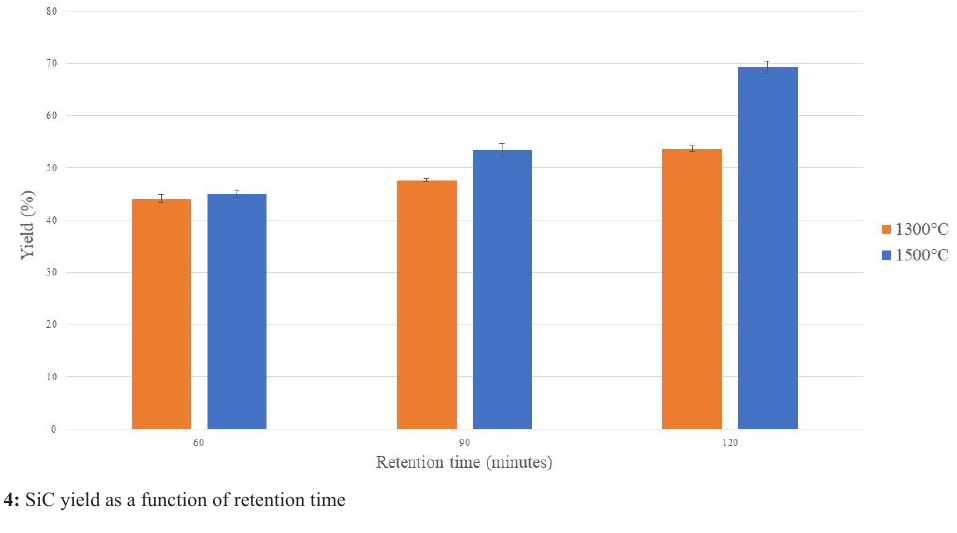
Figure 4: SiC yield as a function of retention time